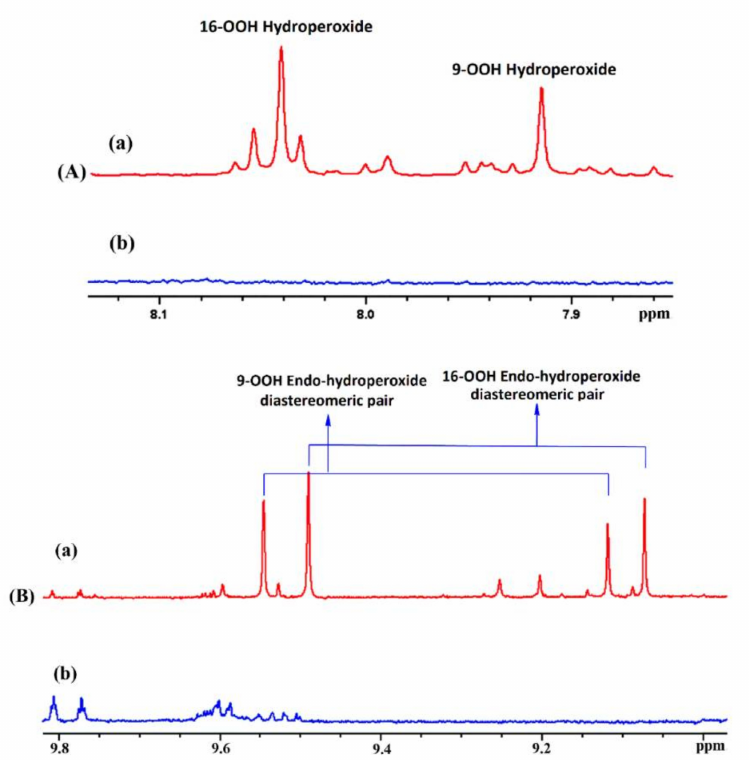
Figure 43. 800 MHz 1 H-NMR spectra of the solution of Figure 42 before the addition ( a ) and after the addition ( b ) of 2 microdrops of D 2 O. ( A , B ) are the selected regions of 7.86 to 8.14 and 8.96 to 9.82 ppm, respectively. For the method of assignment of the -OOH resonances, see text [138].